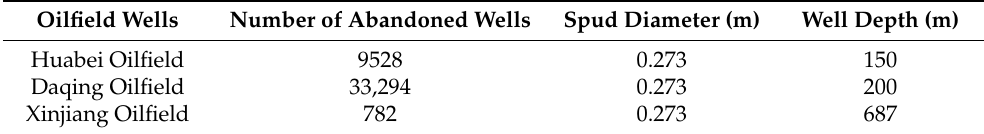
Table 3. Parameters of the abandoned wells in the three selected oilfields. Oilfield Wells Number of Abandoned Wells